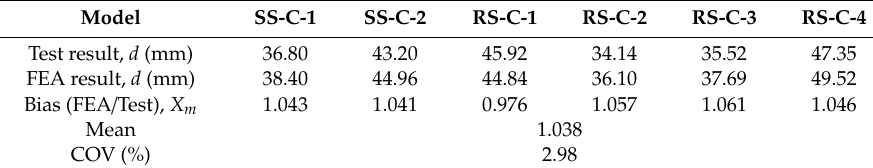
Table 4. Comparison of numerical predictions with the experimental results.